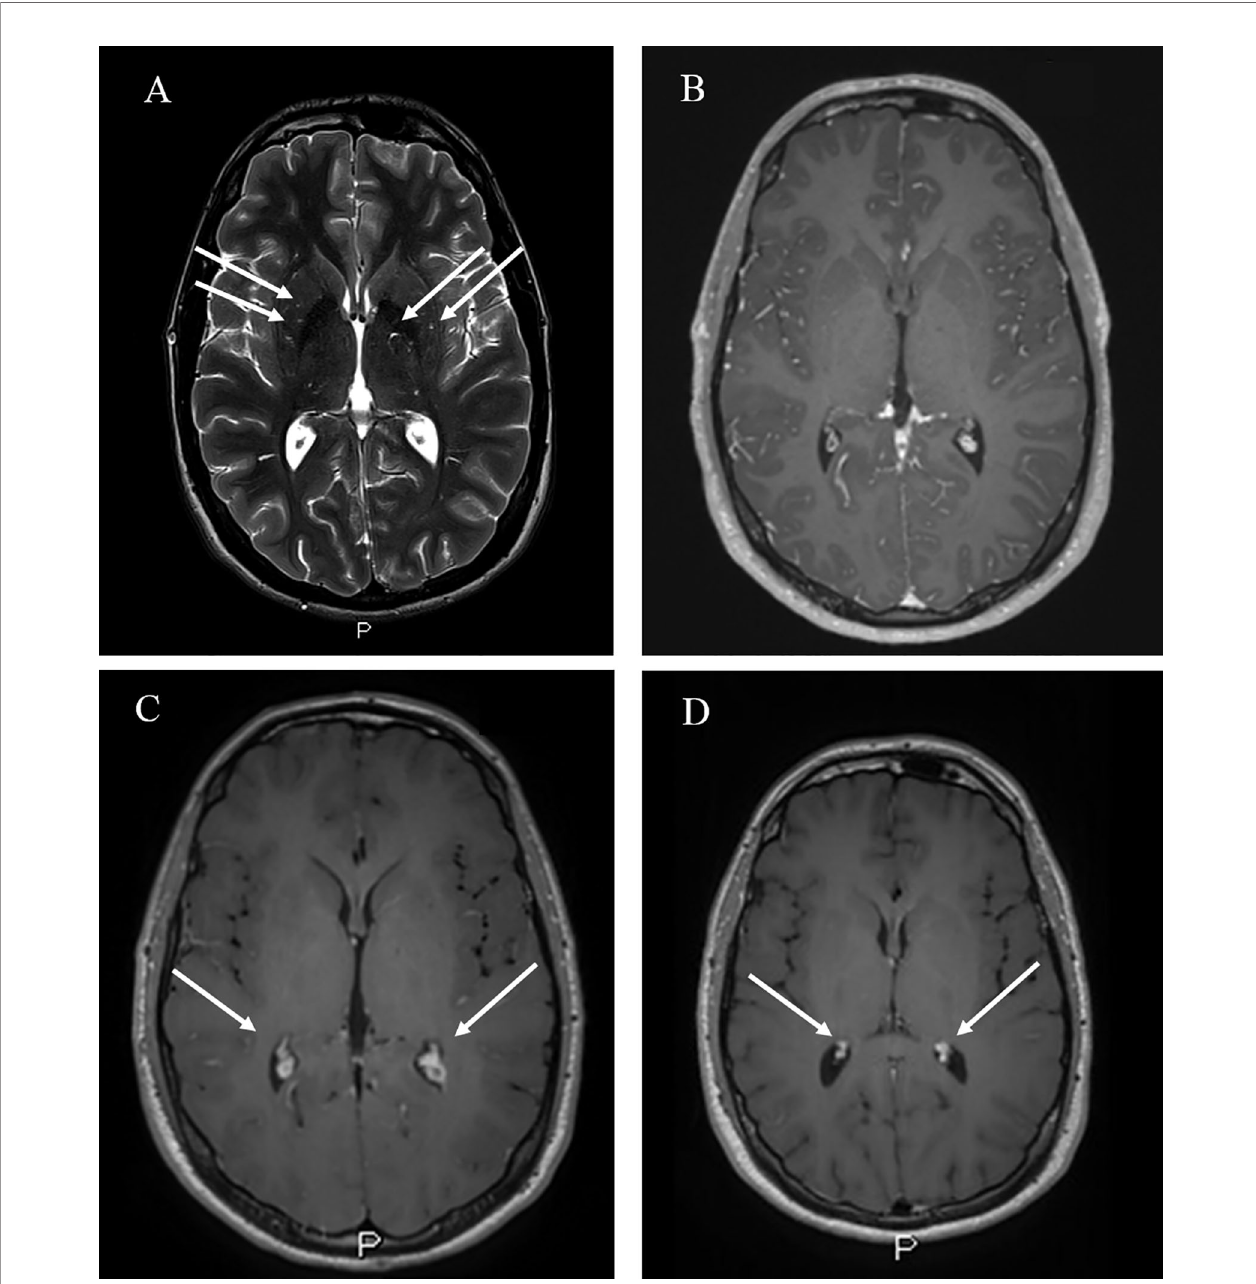
FIGURE 1 | MRI fi ndings of CM in our patients. (A) Abnormally enlarged perivascular spaces in the basal ganglia bilaterally (white arrows) in Axial T2-weighted images (WI); (B) Choroid plexus (white arrows) at the admission in Axial gadolinium-enhanced T1-WI; (C) Bilateral choroid plexitis (white arrows) after ten days of antifungal therapy, in Axial gadolinium-enhanced T1-WI. (D) Absence of choroid plexitis after steroids therapy in Axial enhanced